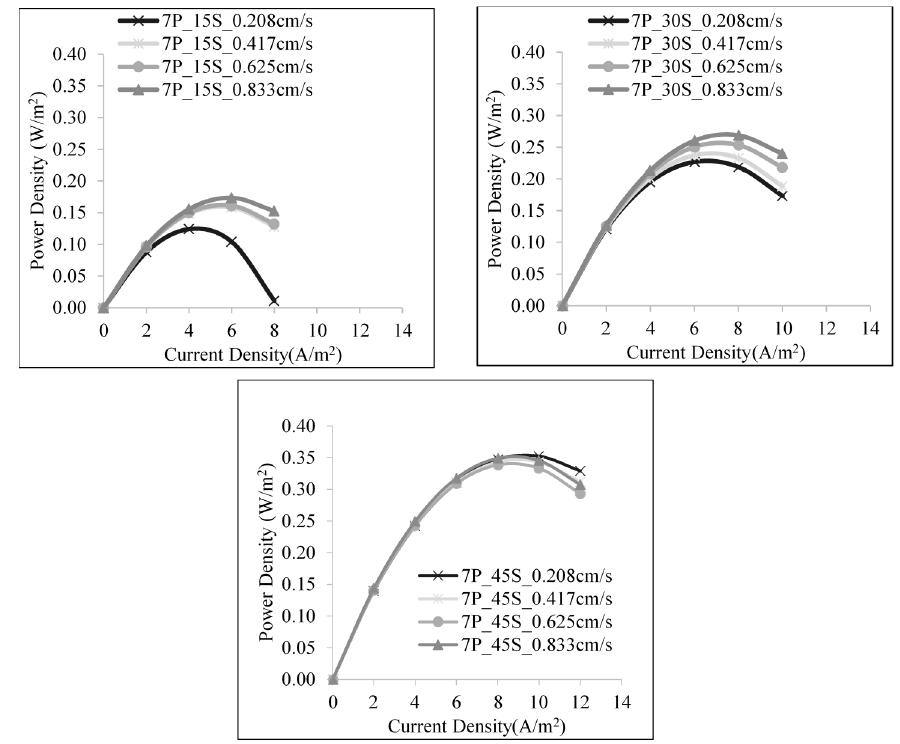
Figure 6. Effect of linear flow rate of feed solutions on power density for 7 pairs of membrane. (XP_YS_Zcm/s indicates X membrane pair, Y salt content of HSS and Z feed velocity).